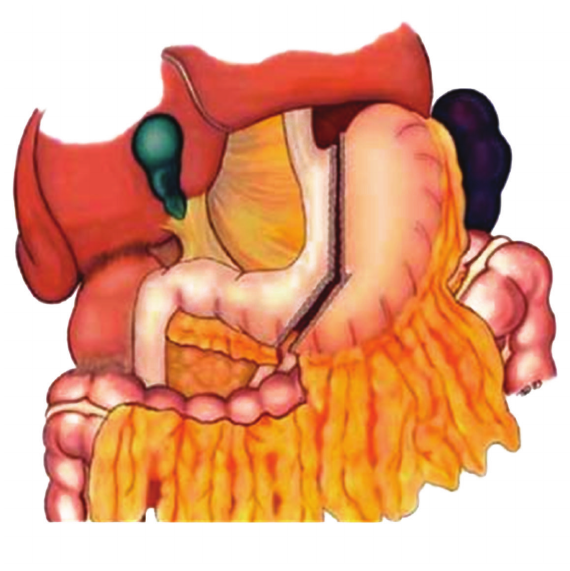
Figure 1: Surgical technique of sleeve